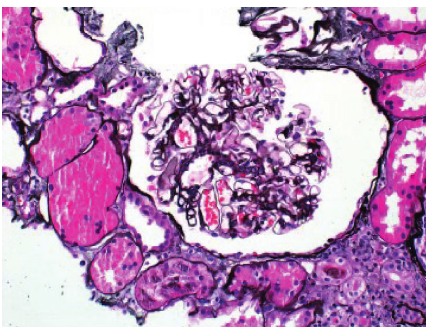
Figure 2: No proliferative glomerular changes.